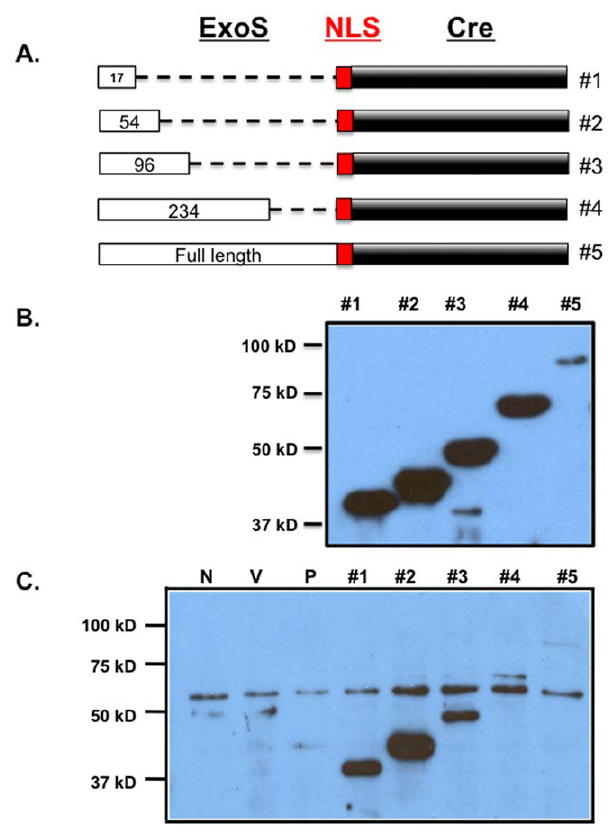
Figure 2. Injection of indicated ExoS-Cre fusions. ( A ) Cre recombinase was fused in frame with various N-terminal portions of ExoS, with a nuclear localization sequence (NLS) in the fusion junction. ( B ) Detection of the five ExS54-Cre fusion proteins in PAK- J D STY harboring the corresponding fusion constructs. Bacterial cells were grown under type III inducing condition and cell lysates were subjected to Western blot using anti-Cre antibody. ( C ) TE26 cells were infected with PAK-J D STY containing the aforementioned constructs, lysed, and subject to Western Blot with anti-Cre antibody. N, no infection control; V, vector control, PAK-J D STY /pUCP20; P, T3SS mutant control, PAK- J D popD /pExoS54-Cre; Lanes1-5 are Cre fusions to ExoS17, ExoS54, ExoS96, ExoS234 and ExoS full length,